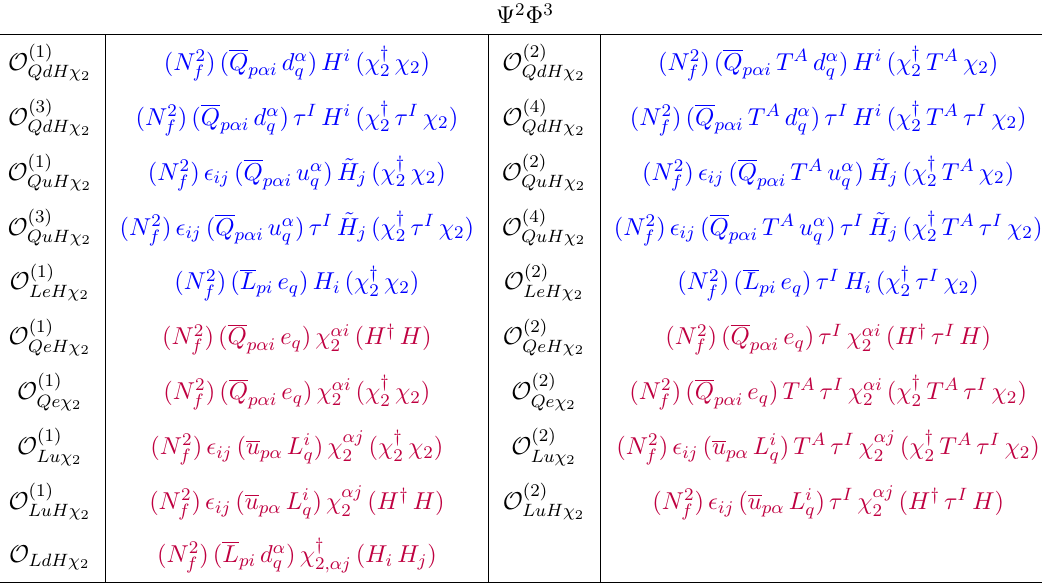
Table 38 . Table 37 continued. Operators in red violate lepton number.